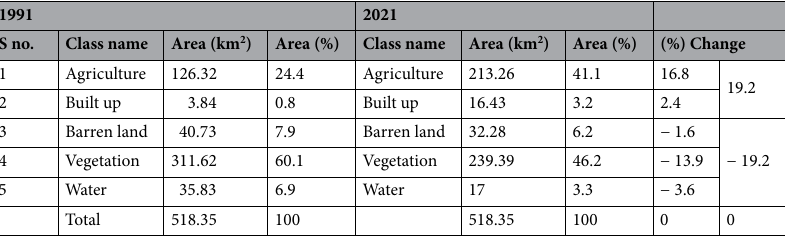
affect the regeneration of forests and rivers, which are tightly linked to rainfall patterns during the monsoon season (June–September). The summary of linear morphometric parameters is given in Table 2. The number of streams (Nu) 20 decreased from 1511 (1977) to 175 (2021), while the total length of streams (Lu) 18 shrank from 1286.92 km (1977) to 381.95 km (2021), resulting in the conversion of the 6th order Banki into the 4th order river (Fig. 1). The 1st order streams still exist on the low dissected structural hills without forming 2nd order streams. Moreover, the hetero- geneous dendritic drainage network is transformed into flat and homogenized terrain dominated by agriculture practices and rural and periurban settlements. Now, the 2nd and 3rd order streams become 1st order streams, and 3rd and 4th order streams are enumerated as the 2nd order streams, and so on. This trend is disrupting the continuum of morphological and hydrological features from the headwaters to the mouth 11 and the consequent unpredictable impact on water level pulsing on the resulting floodplain, i.e., “aquatic/terrestrial transition zone”